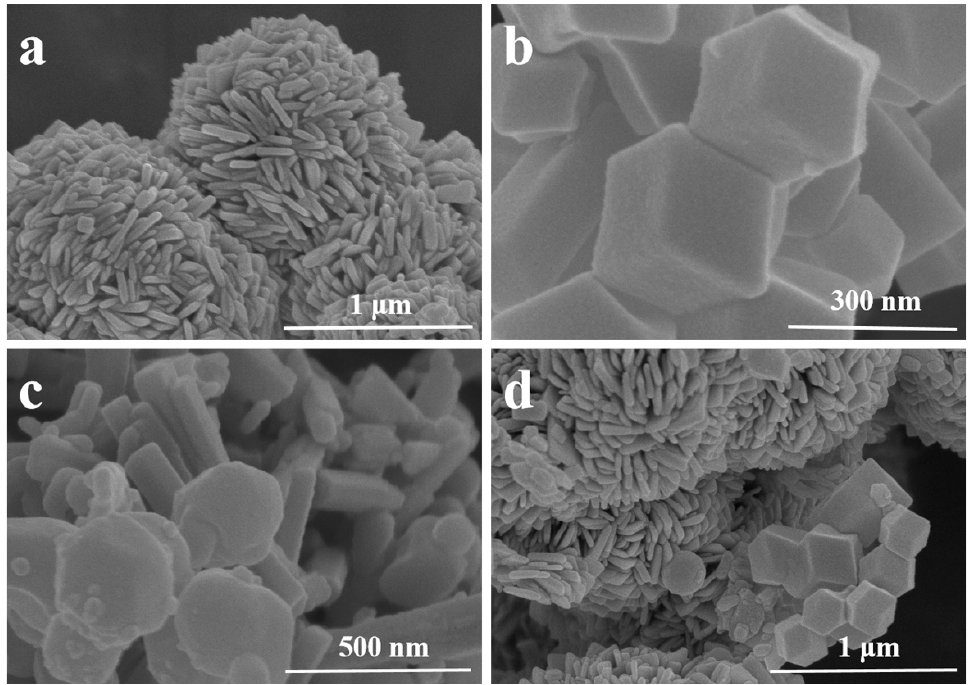
Figure 2. SEM image of ( a ) BiOBr; ( b ) ZIF − 8; ( c ) ZZ − 110; and ( d ) BZ −